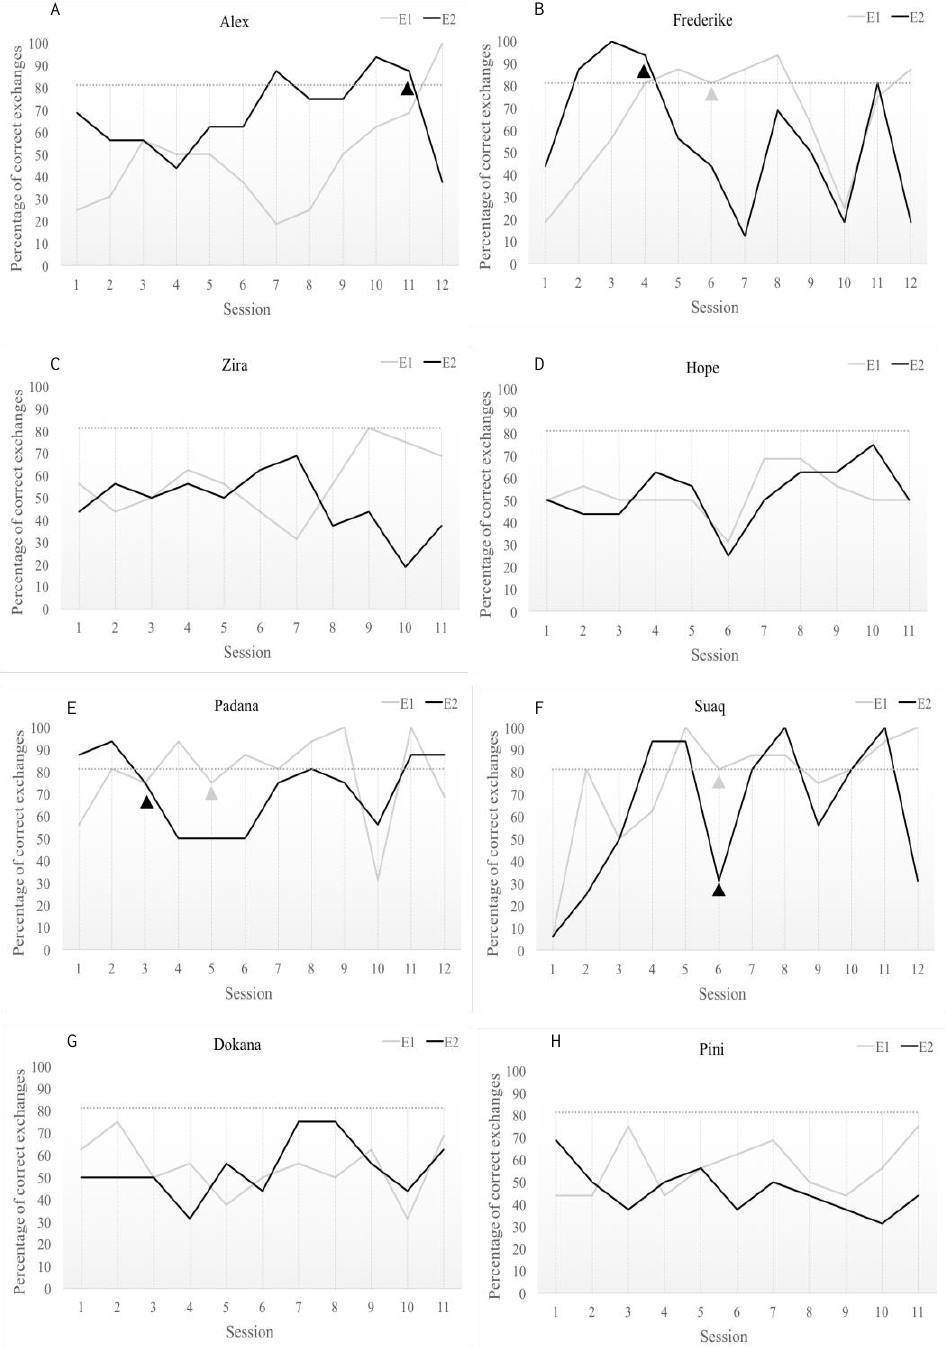
Figure 7. Percentage of correct exchanges with E1 and E2 by session for each subject. Only the first four exchanges of each trial in a session were counted, resulting in a total of 16 exchanges per session. Dotted line shows pass criterion (13/16 correct exchanges; 81.25%